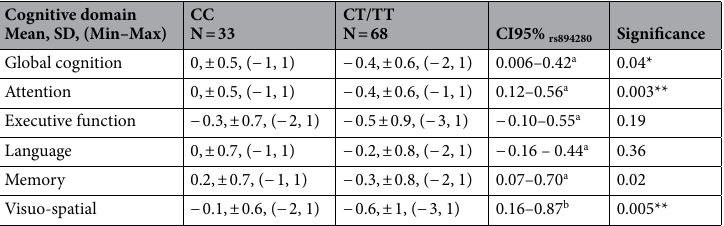
Table 4. Results of ANCOVA analysis of rs894280, and global cognition and the five cognitive domains. SD = Standard Deviation, CI 95% = 95% confidence intervals. a UPDRS-III, Education, R rostral-anterior cingulate and L middle temporal thickness measures were entered in the model. b UPDRS-III, Education, R rostral-anterior cingulate and L middle temporal thickness measures and EHI score were entered in the model. *Significance level was set to 0.05. **Significance level was set to 0.01, Bonferroni